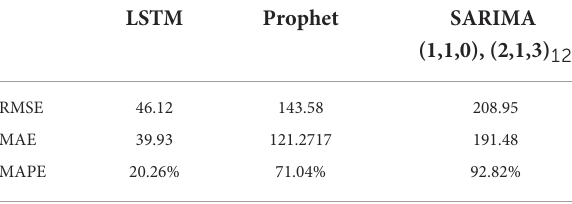
TABLE 3 LSTM, Prophet, and SARIMA prediction effect evaluation parameters.